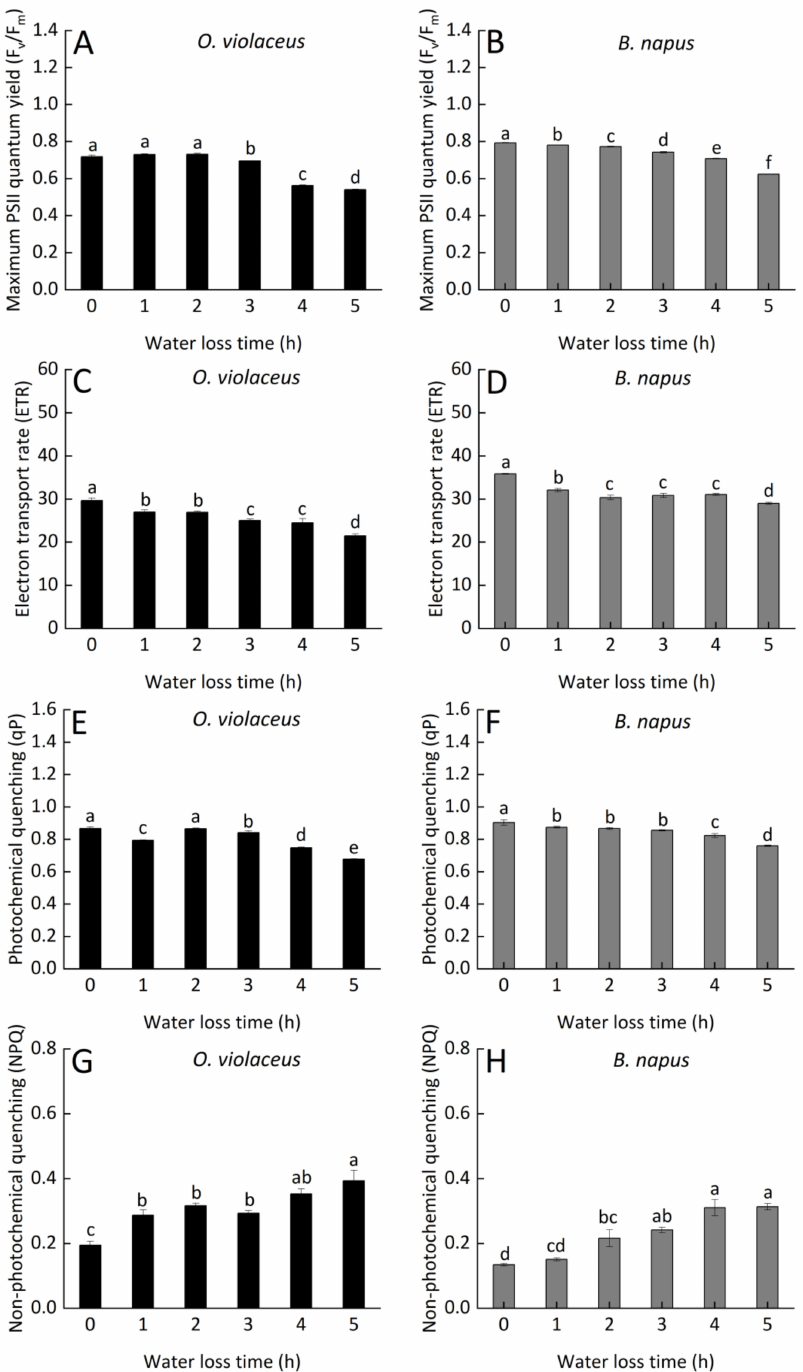
Figure 3. The F v /F m , ETR, qP and NPQ of O. violaceus and B. napus at different dehydration times (Note: ( A , C , E , G ) are the F v /F m , ETR, qP, NPQ of O. violaceus , respectively; ( B , D , F , H ) are the F v /F m , ETR, qP, NPQ of B. napus , respectively. Different letters appear above the error bars of the same parameter in the same plant species when subsequent values differ significantly at p ≤ 0.05, according to one-way